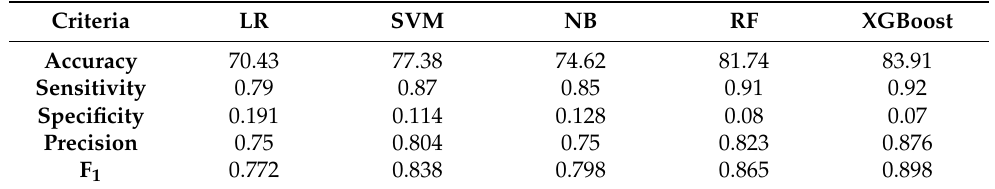
Table 3. Comparison of applied machine learning algorithms (cid:48) performances with data augmentation.